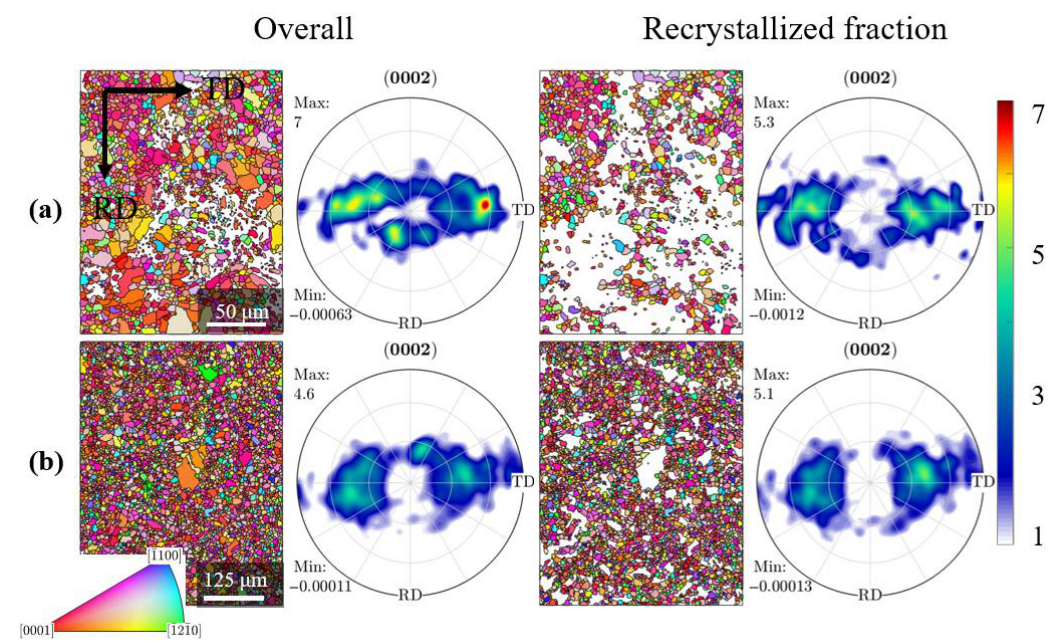
Figure 9. EBSD IPF maps (with respect to ND) and their (0002) pole figures of Mg-1%Er-1%Zn annealed at 350 °C for 5 min ( a ) and 10 min ( b ). The left column features the overall map data, and the right column only the recrystallized fraction with GOS < 1°.